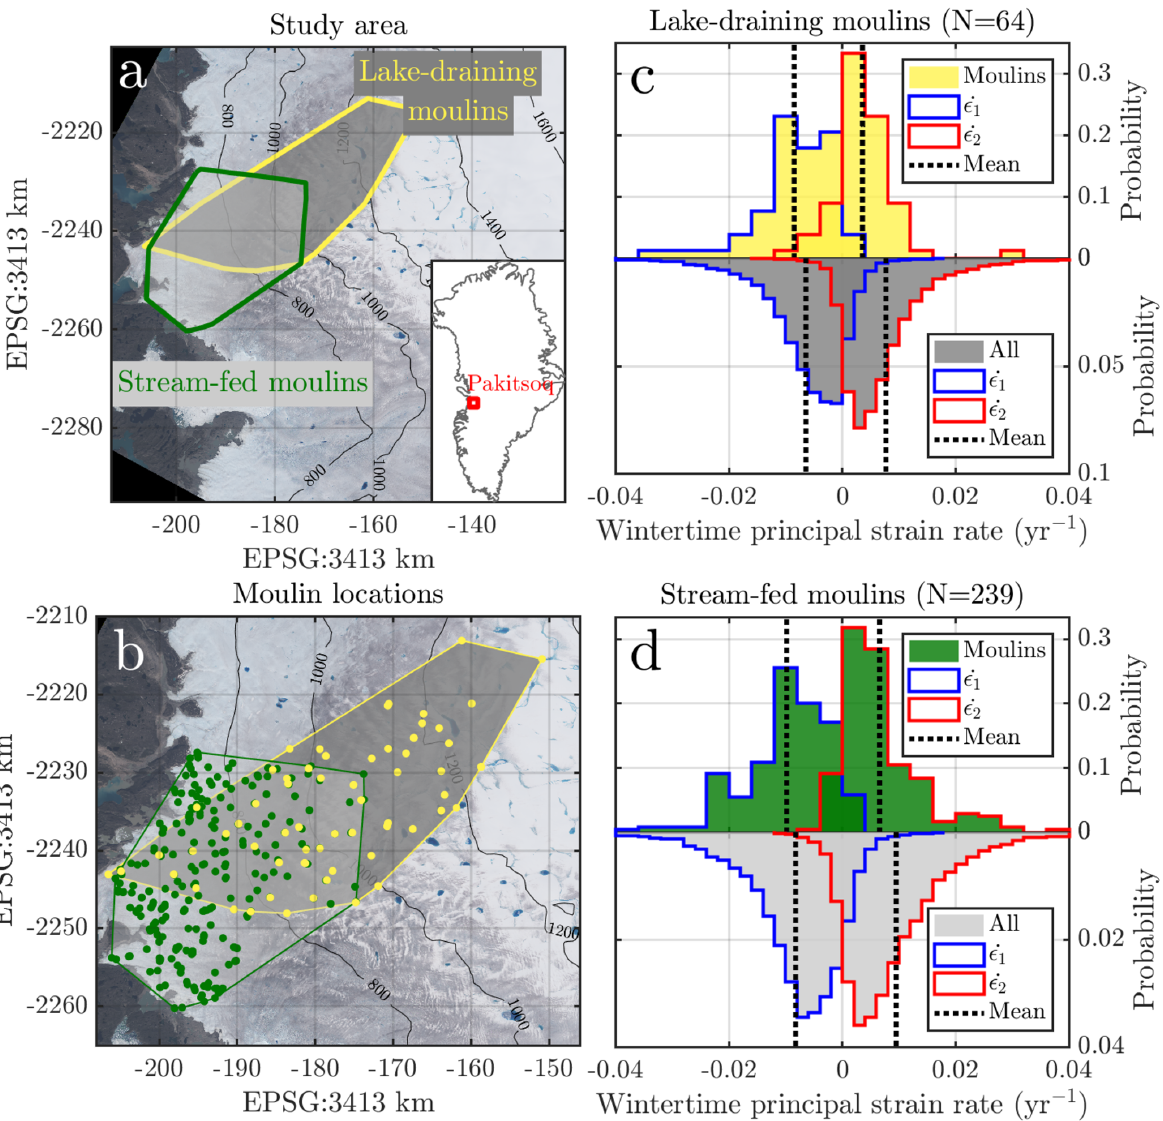
Figure 5. Study area and wintertime-average strain rates. (a) The Pâkitsoq area in western Greenland (inset), with the region where we have identified lake-draining moulins (Morriss et al., 2013) in gray and yellow and the regions where we have identified stream-fed moulins (Andrews, 2015) in light gray and green. (b) Locations of the 78 lakes (yellow) from Morriss et al. (2013) and 239 stream-fed (green) moulins identified in 2011 (Andrews, 2015; Hoffman et al., 2018). We identified mean locations of the moulins that drain 66 of the 78 lakes over 2009–2019 (not shown). (c) Long-term average wintertime strain rates ˙ (cid:15) 1 and ˙ (cid:15) 2 at the 66 mean locations for lake-draining moulins (yellow), and at all locations in the lake-draining region (gray). (d) Long-term average wintertime strain rates at the 239 stream-fed moulins and at all locations in the stream-fed region (gray). Means are shown as black dashes and are significantly lower at moulin sites ( p < 0 . 05) than the regional background, for both ˙ (cid:15) 1 and ˙ (cid:15) 2 , and for lake-draining moulins and stream-fed moulins. Strain rates are calculated from the NASA MEaSUREs Multi-year Greenland Ice Sheet Velocity Mosaic, Version 1 (Joughin et al., 2016a,